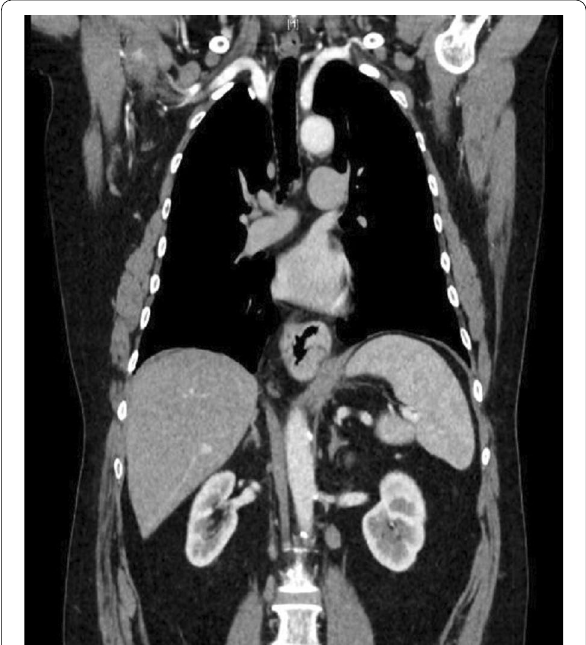
Fig. 2 CT CAP showing no significant